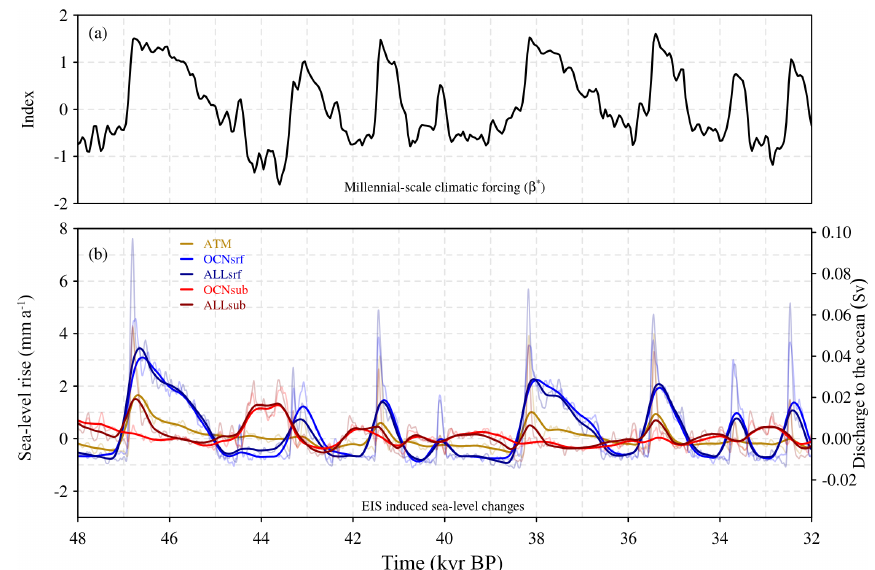
Figure 5. MIS 3 period. (a) Temporal component of the millennial-scale climatic forcing ( β (cid:63) index), and (b) EIS changes (in millimeters per annum and Sv) related to ice volume variations with respect to initial conditions for the CTRL run (black) and for the SL (gray) ATM (gold), OCN srf (blue), OCN sub (red), ALL srf (dark blue) and ALL sub (dark red) forcing experiments. Thick lines show the variables after applying a low-pass filter of 100